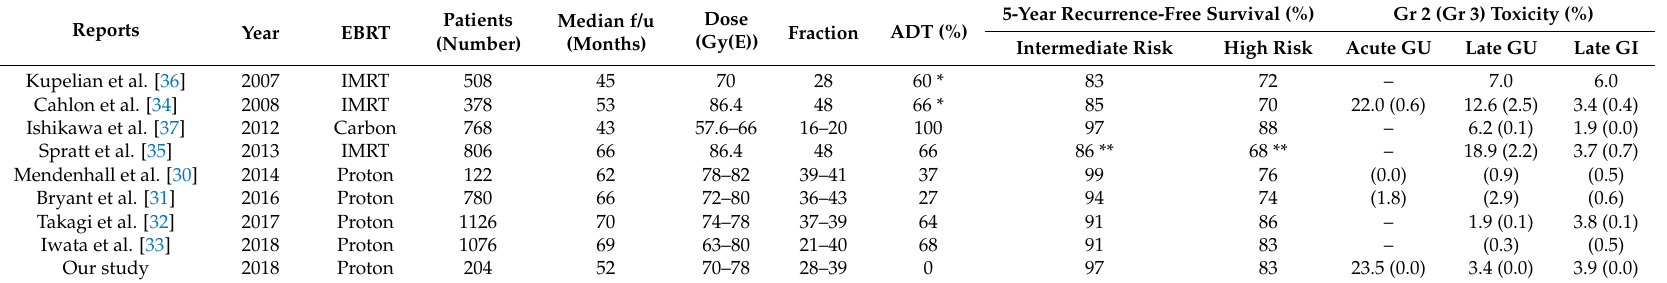
Table 4. Comparison with previous reports on radiotherapy for intermediate- and high-risk